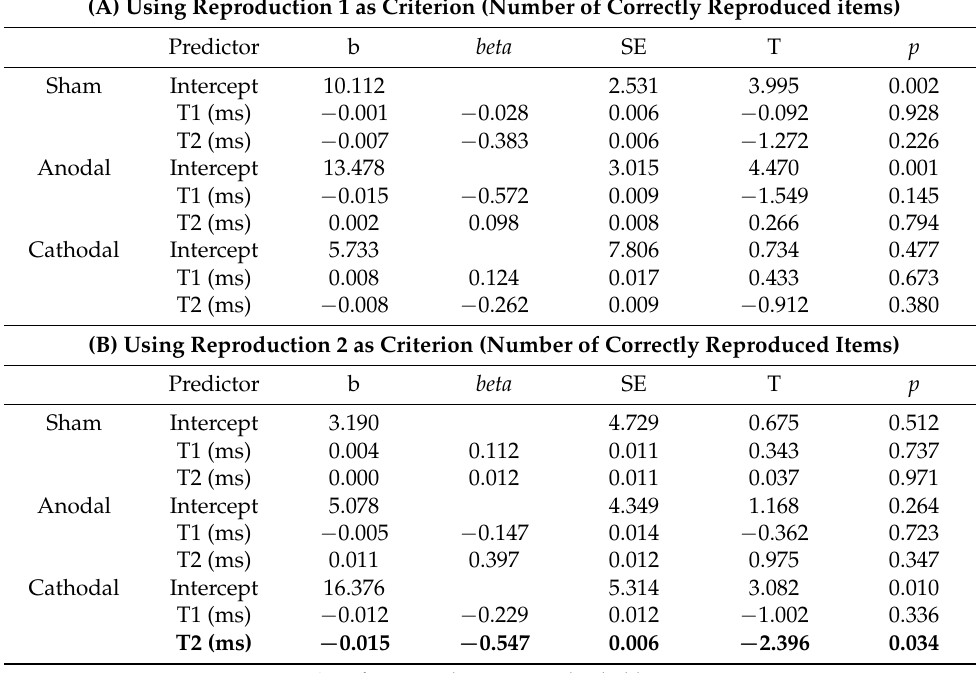
Table 2. Regression analyses.